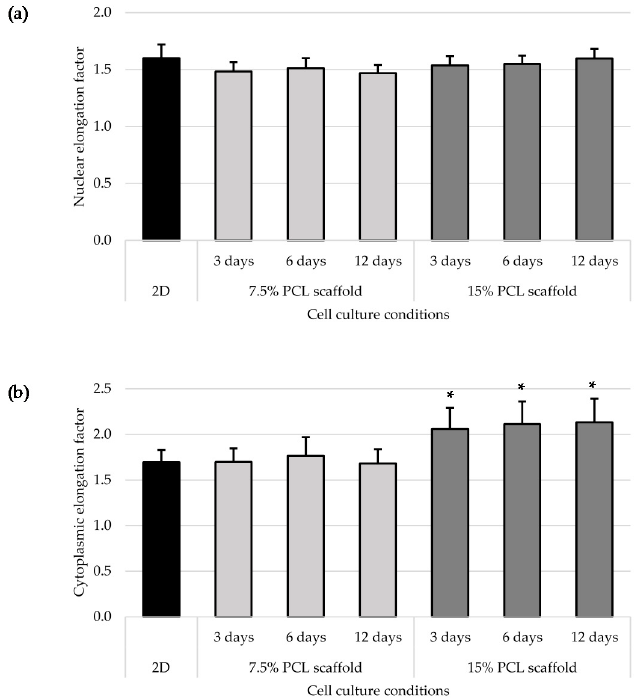
Figure 4. Cell morphology analysis for MDA–MB–231 cells cultured on two-dimensional surfaces (2D) and on 7.5% and 15% PCL scaffolds. Nuclear ( a ) and cytoplasmic elongation ( b ) were measured as explained in Section 2.7. Scaffolds values were compared with 2D culture and levels of statistically significance were indicated as * ( p < 0.05).